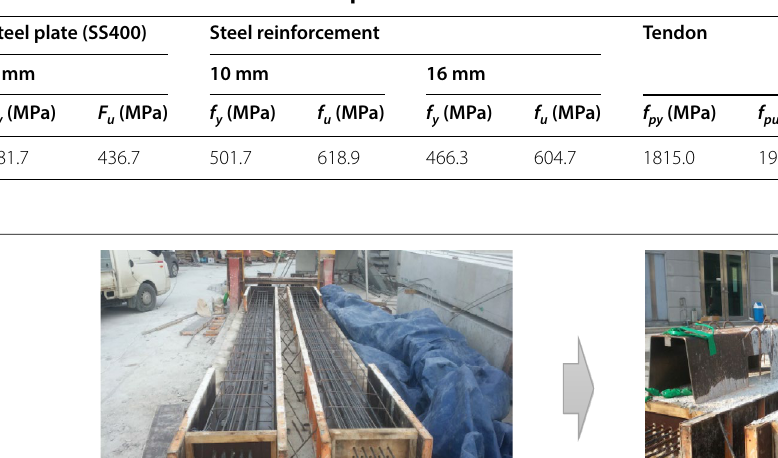
Table 1 Dimensional details of test specimens.